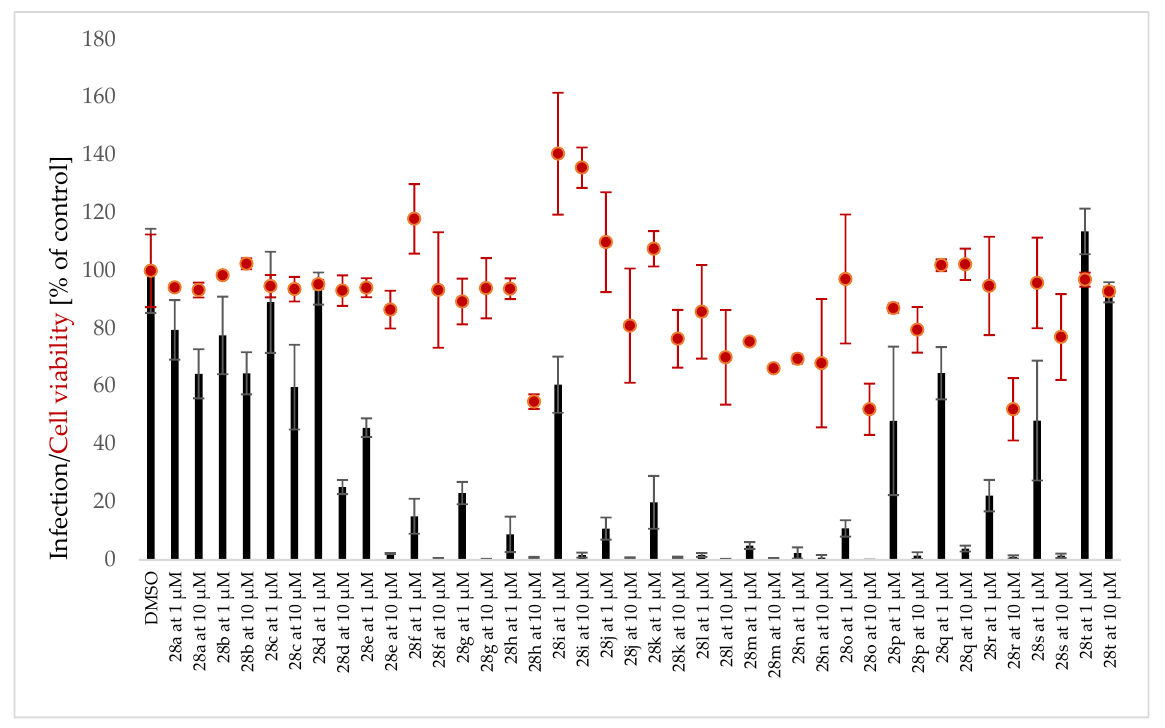
Figure 4. Screening of inhibitory activity of ambelline derivatives against the hepatic stage of Plasmodium berghei in Huh-7 cell line .